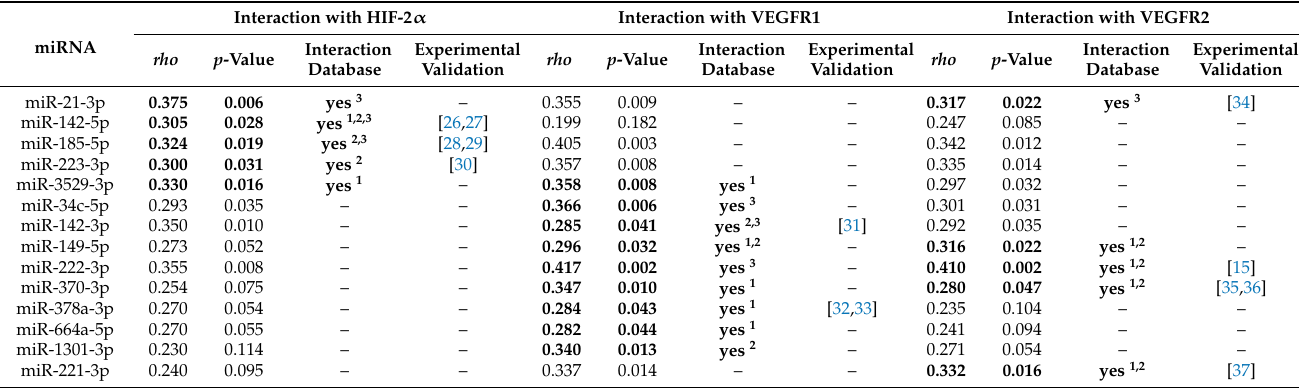
Table 2. miRNAs inversely correlated with HIF-2 α , VEGFR1 or VEGFR2 expression and listed by miRNA–mRNA inter-